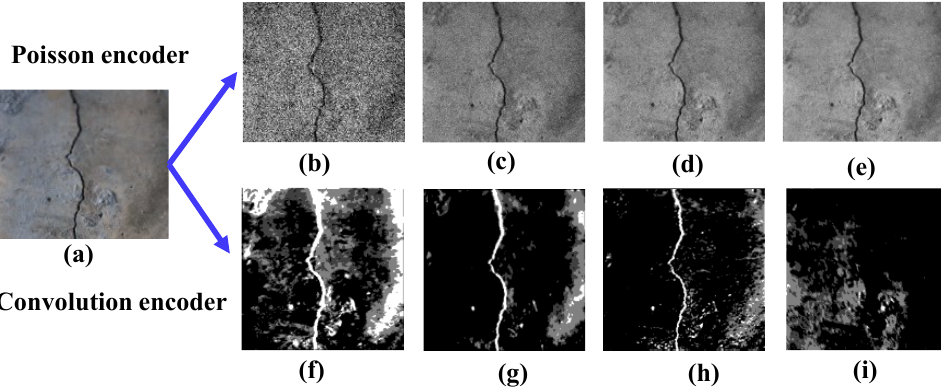
Figure 6. The spike encoding for the input image. ( a ) the original input image. ( b – e ) represents the accumulative output of the Poisson encoder at observation time T = 0, 7, 15, 31, respectively. ( f – i ) represents the cumulative feature map output of the convolutional encoder at T = 3, four channels were randomly selected from 64 channels.